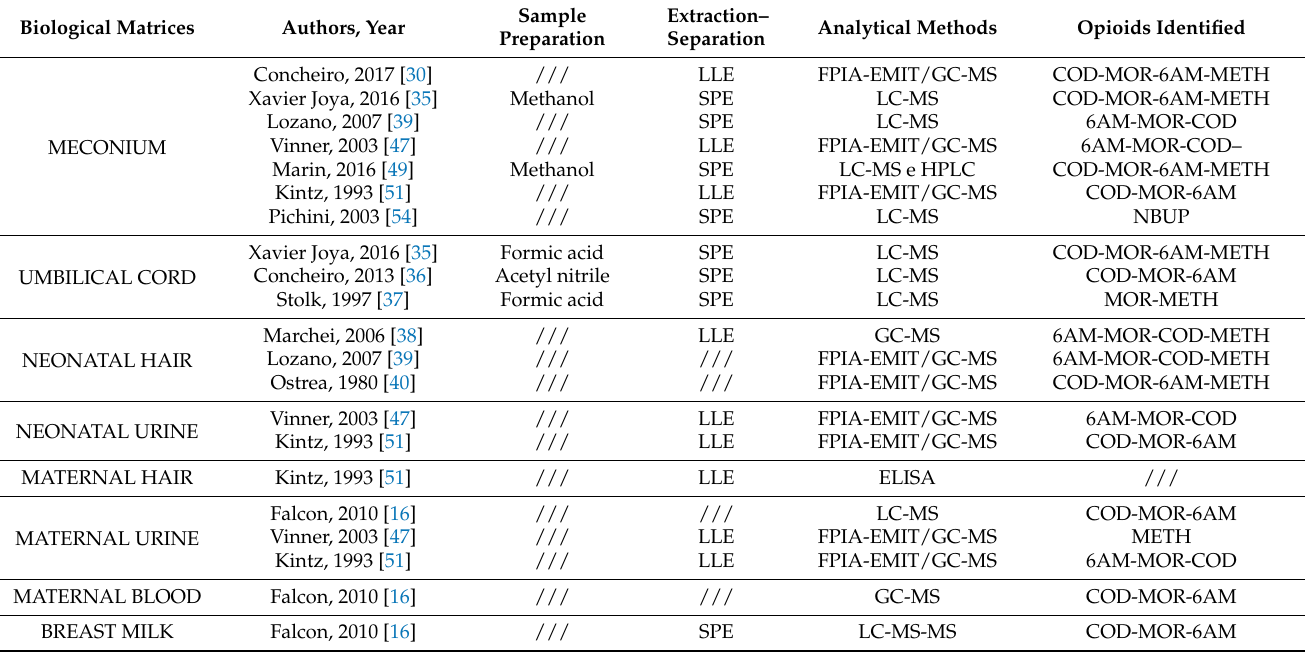
Table 3. A summary of the analytical methods to detect opioids in maternal and neonatal